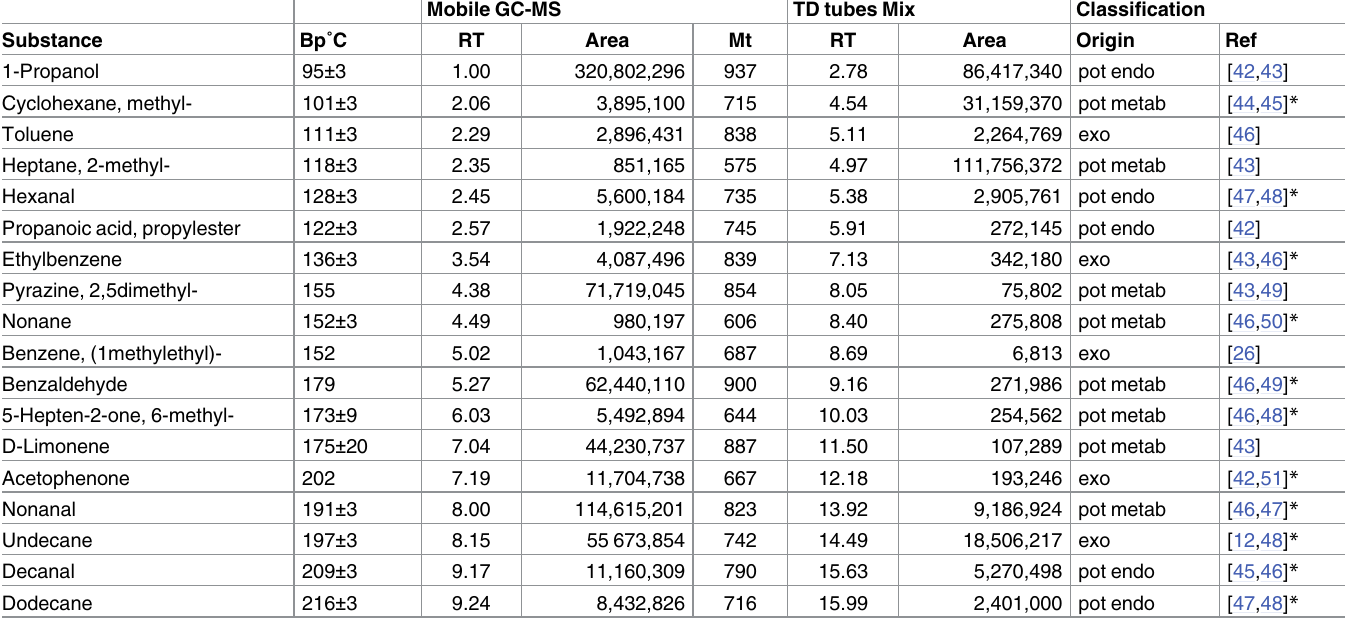
Table 2. Compounds in common to TD tubes Mix and mobile GC-MS samples. adsorbent materials are similar, we correlated the relative mean areas of compounds retrieved with TD tubes Mix with both TD tubes Tenax TA and TD tubes XAD-4. Beforehand, we evalu- ated the accurate assignment of shared compounds by correlating their retention times. In agreement with a correct assignment, the retention times of the compounds analysed from TD tubes Mix highly correlated with both Tenax TA and XAD-4 (Spearman rank correlation, tions of relative mean areas revealed no significant relationship between the methods at all (Spearman rank correlation: Tenax TA: N = 20, r = 0.06, p = 0.776; XAD-4: N = 6, r = -0.31, p = 0.564). Thus, compounds exhibited a completely different response pattern with the differ- ent adsorbent materials and combinations. In particular, two compounds which were exceed- ingly more abundant in TD Mix tubes than expected by comparison to Tenax TA were both ketones and two compounds which were recovered with a remarkably lower intensity in TD Mix tubes were both alcohols (data not shown).